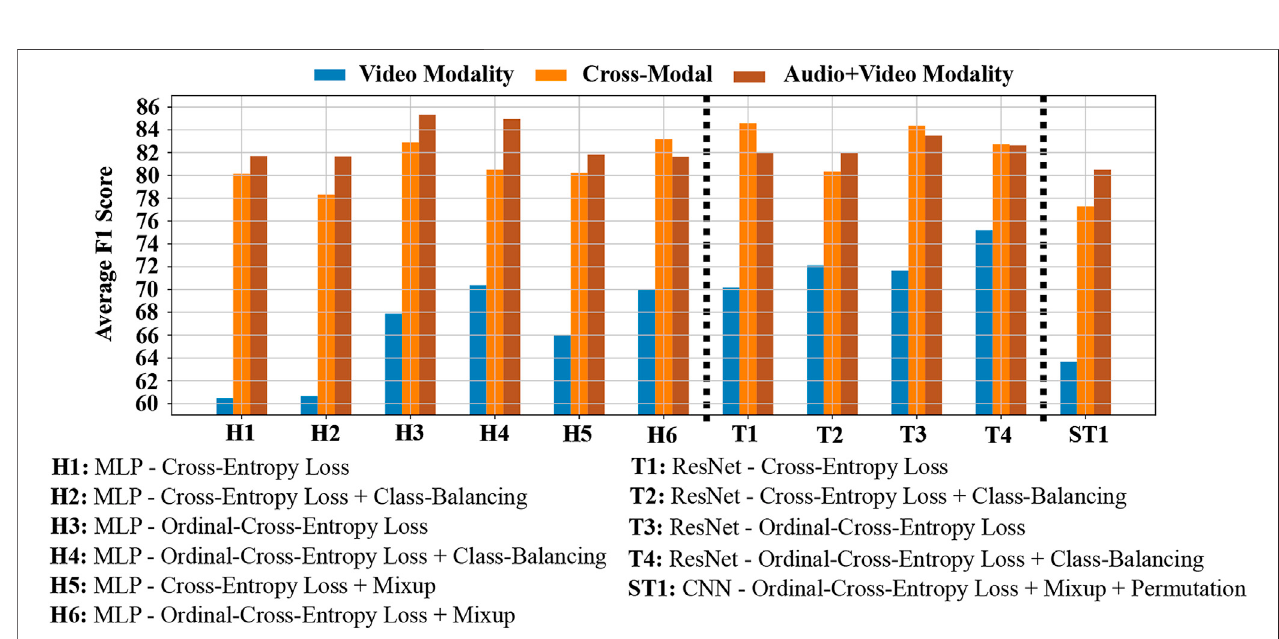
FIGURE 10 | Weighted F1-score performance of the different Level C features in the Video, Cross-modal and Audio + Video modality settings.